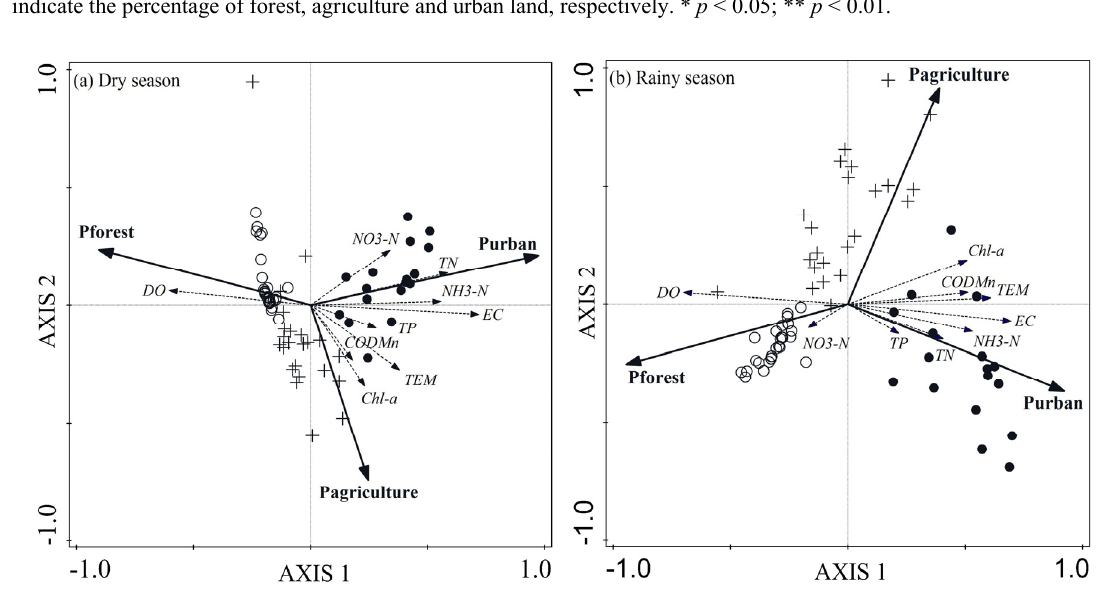
Figure 5. Tri-plot results of redundancy analysis: water quality parameters and land use variables in the dry season ( a ) and in the rainy season ( b ). Different symbol represent different site groups (forest-dominated sites: ○ ; agriculture-dominated sites: +; urban-dominated sites: ●